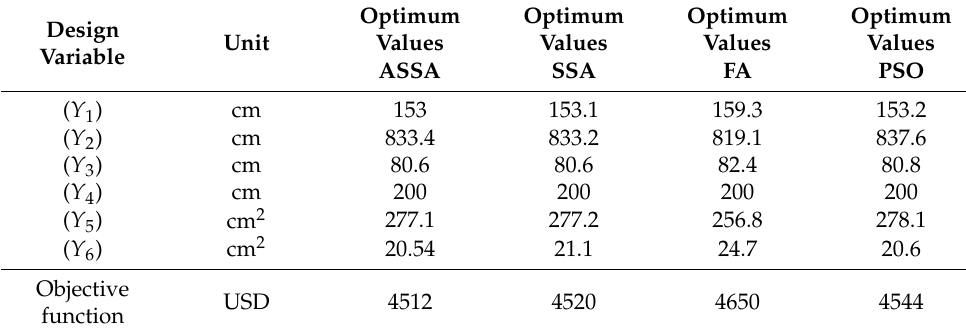
Table 16. Optimization result for design example 2.